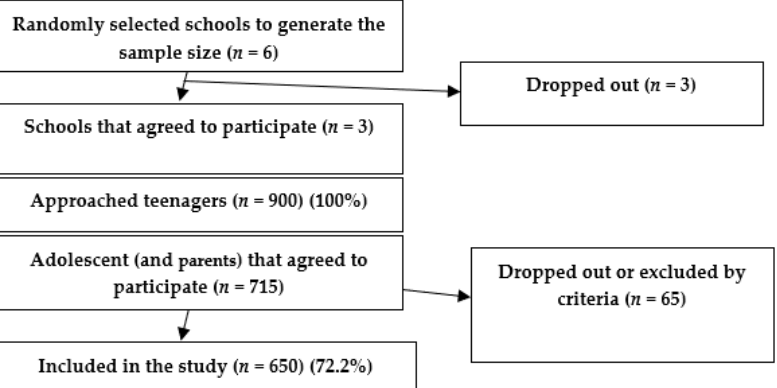
Figure 1. Reporting flow diagram (guideline).